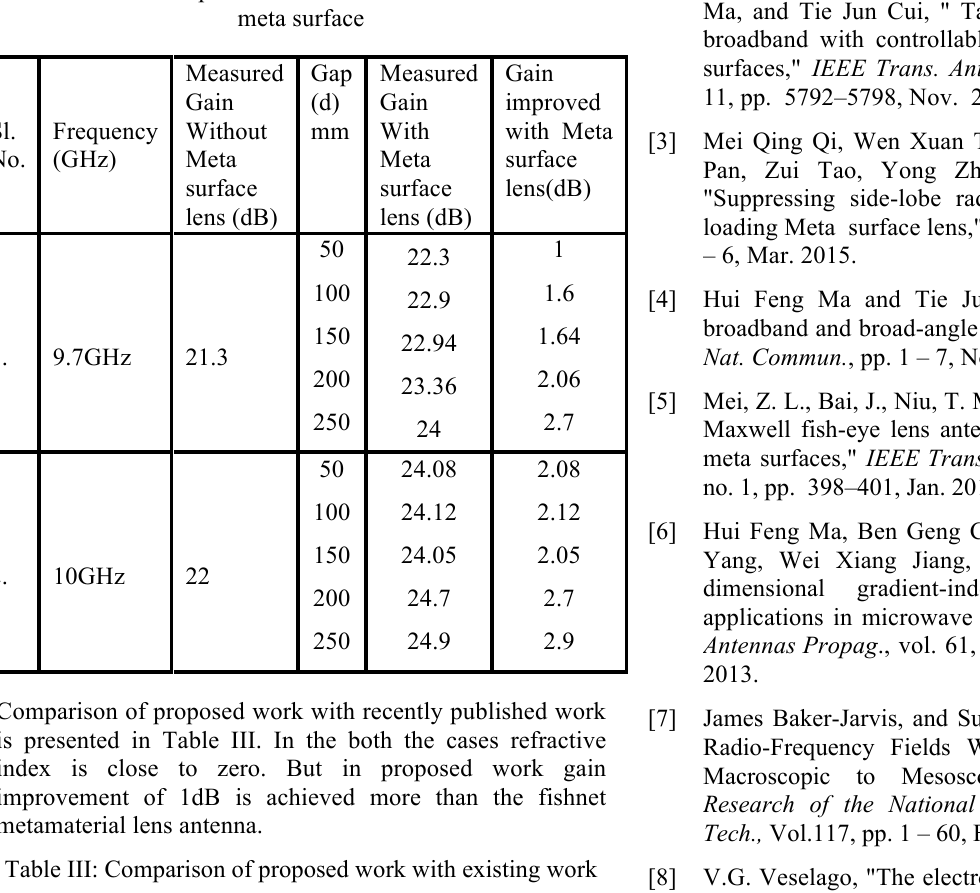
Table III: Comparison of proposed work with existing work